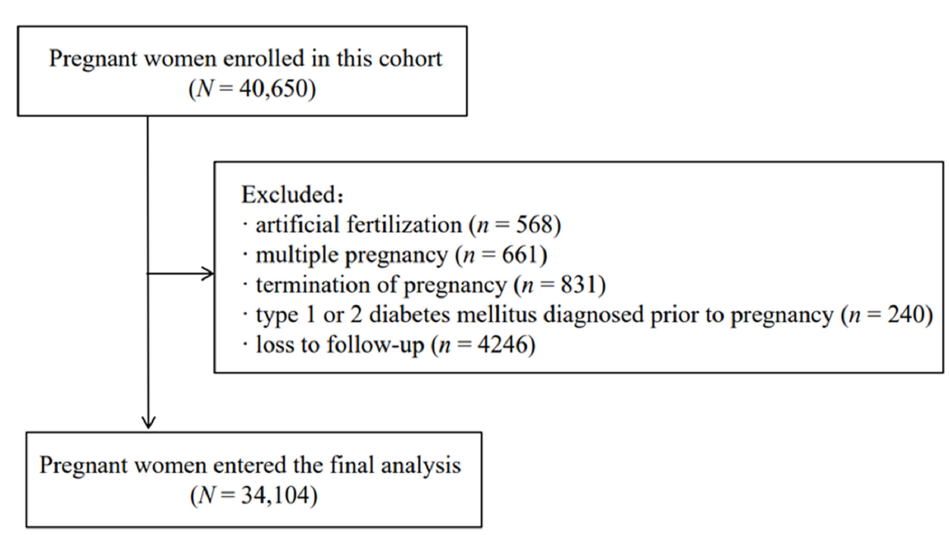
Figure A1. Flow chart showing the process of participant’s recruitment.